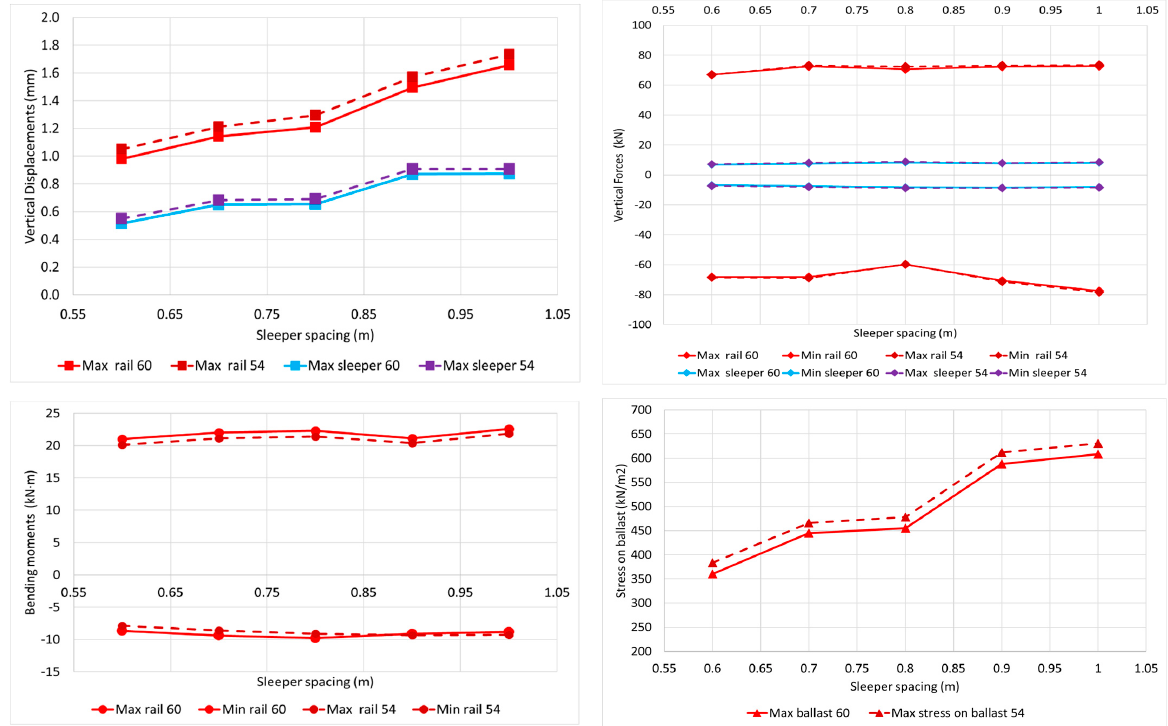
Figure 5. Case 3. Maximum vertical displacements of the rail and sleeper, vertical forces on rail and sleeper, rail bending moments, and stresses on ballast . sleeper, rail bending moments, and stresses on